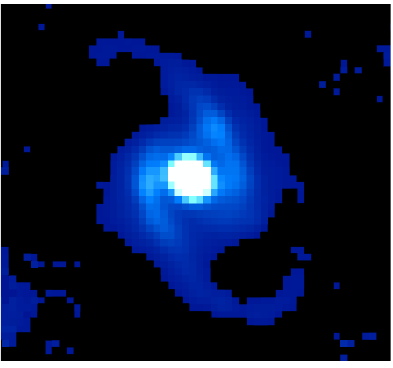
Figure 2: SFR map of NGC 1365, obtained from the grey body IR luminosity integrated between 8 and 1000 µ m.